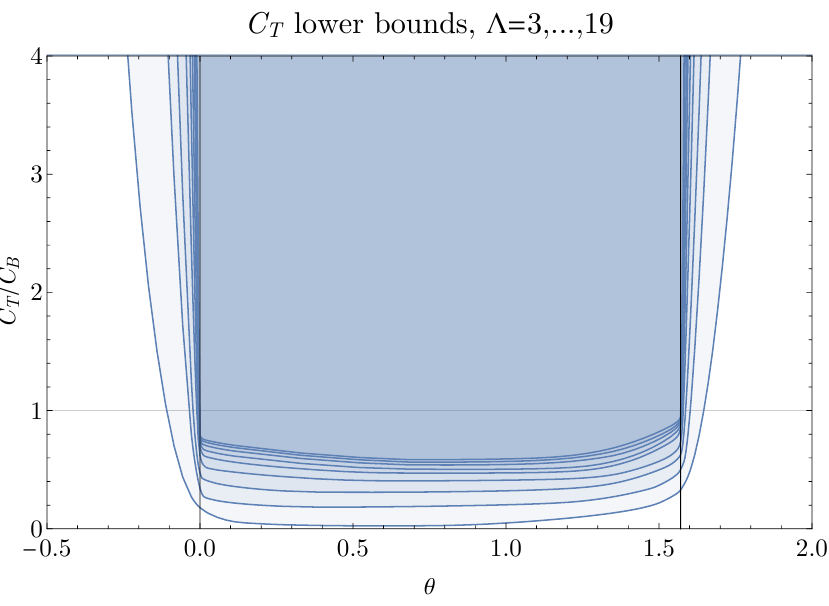
Figure 2 . A series of lower bounds on C T as a function of (cid:18) , valid in any unitary parity-preserving 3d CFT. The shaded region is